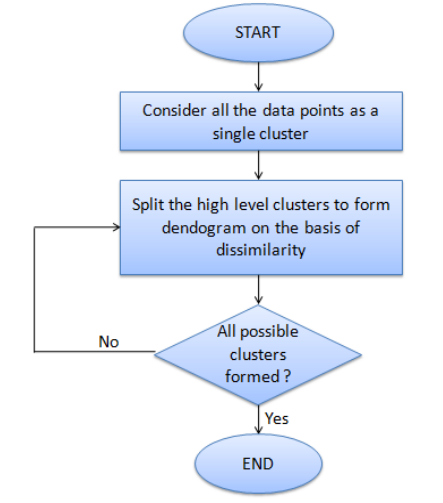
Fig. 12. Divisive hierarchical algorithm.